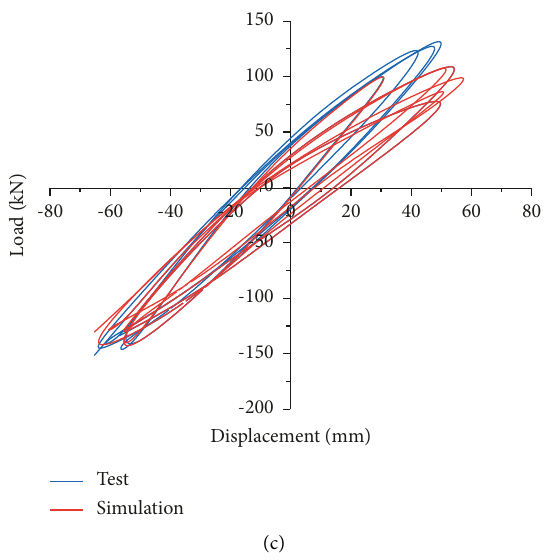
Figure 12: Comparison of hysteretic curves. (a) CSFT-1, (b) CFST-2, and (c) CFST-3.